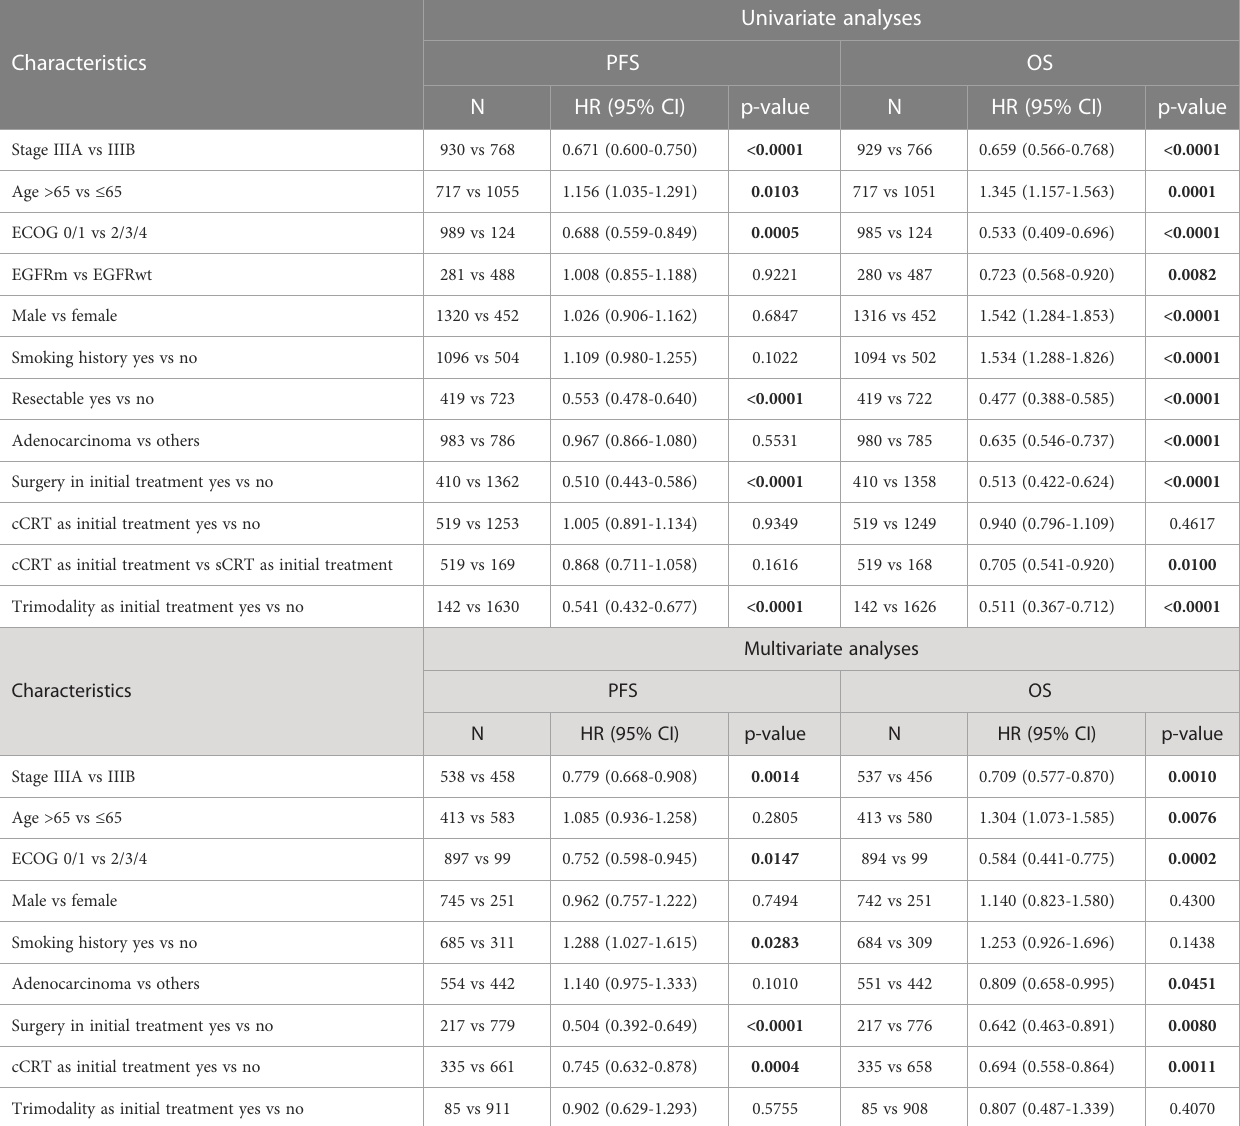
TABLE 4 Univariate and multivariate analyses for survival outcomes in KINDLE-Asia.